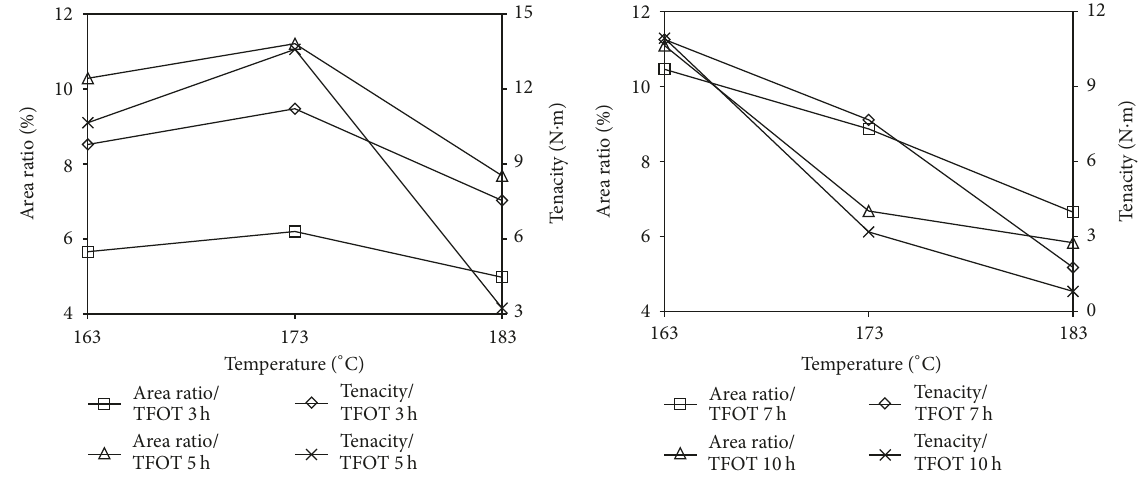
Figure 8: Correlation of SBS particle area ratio and tenacity with aging temperature. Table 6: Correlation of microstructure indexes, toughness, and tenacity with aging